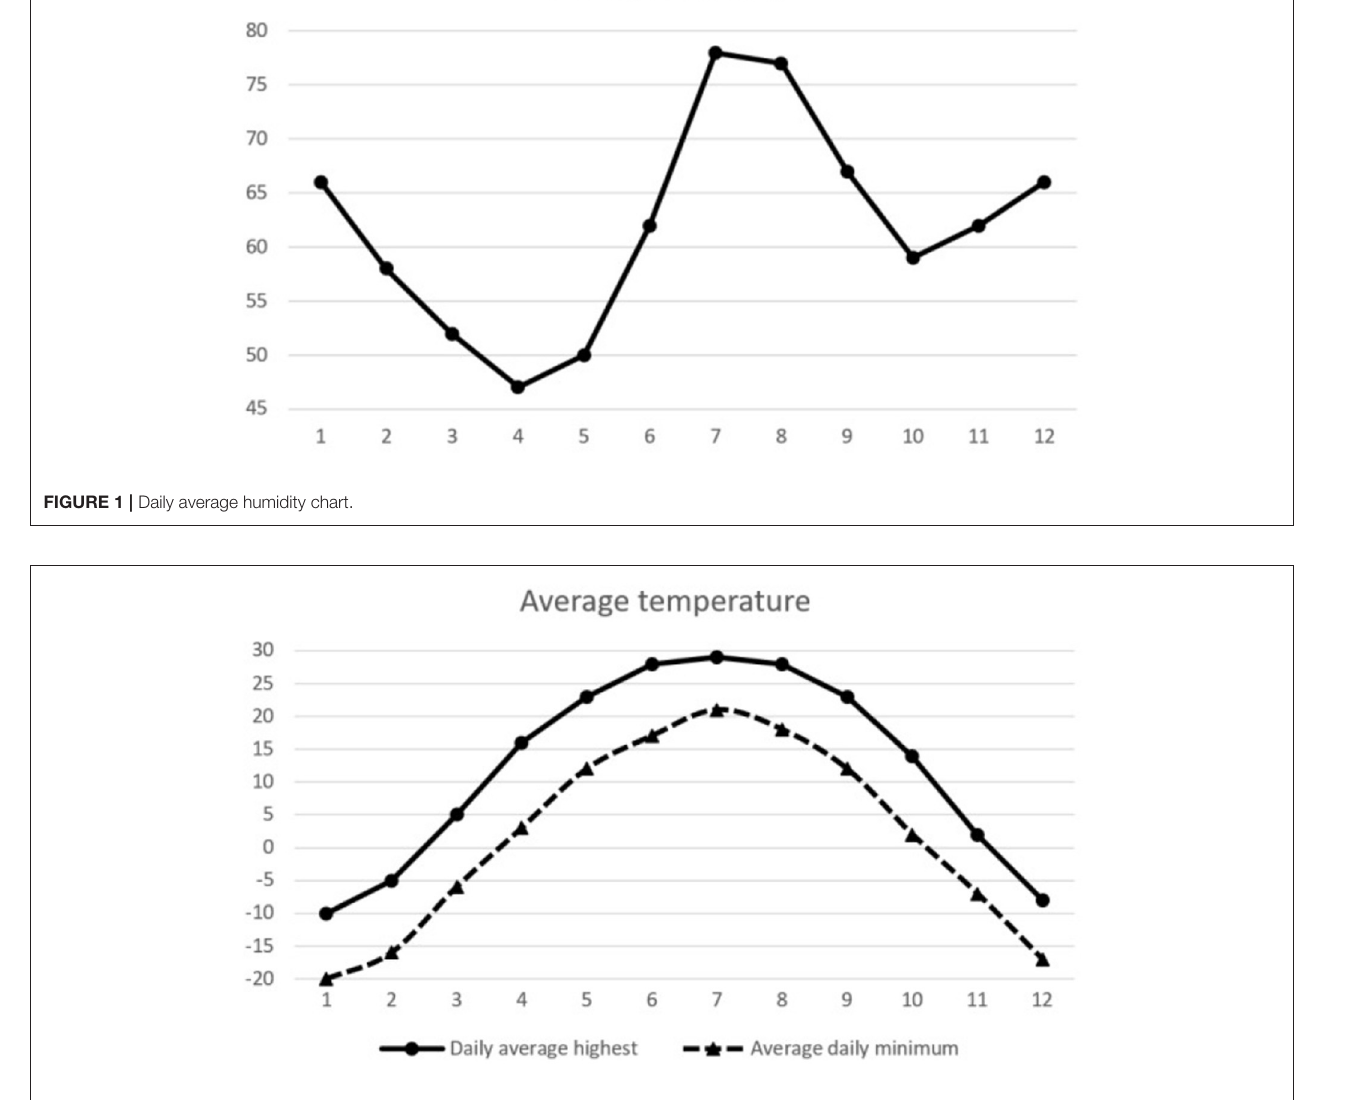
Figure 4C . With the passage of time, the random fluctuation in time series seems to be almost unchanged, presenting a normal distribution rule, as shown in Figure 4D